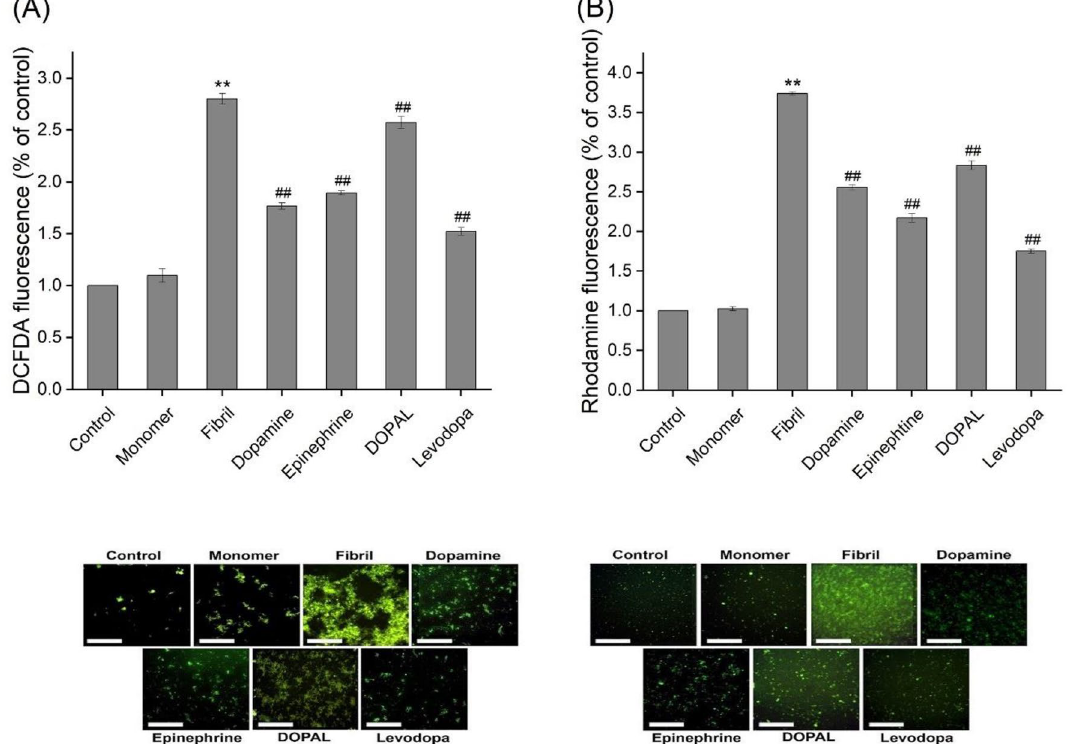
Figure 9. The effect of catechols on the α-syn aggregates-induced mitochondrial ROS enhancement ( A ) membrane depolarization ( B ). Mitochondrial suspensions (1 mg/mL) were incubated alone or with 5 µM α-syn aggregates, produced in the absence or presence of 200 µM catechols. Untreated mitochondria (control) and those treated with 5 μM α-syn monomer are also indicated. Low panels show fluorescence microscopy images of incubated samples. The scale bar represents 100 μm. Data are expressed as mean ± SD with n = 3. ** p < 0.01 significantly different from control. ## p < 0.01 significantly different from mitochondria exposed only to α-syn amyloid